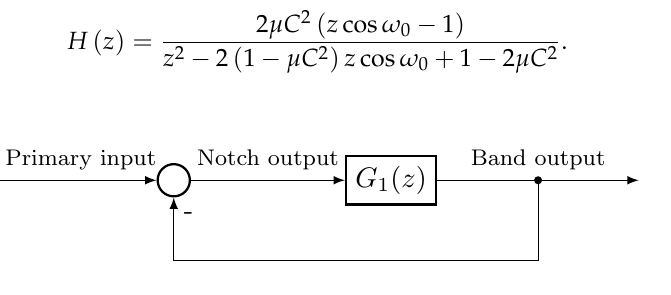
Figure 8. The linear transfer function for the adaptive filter.